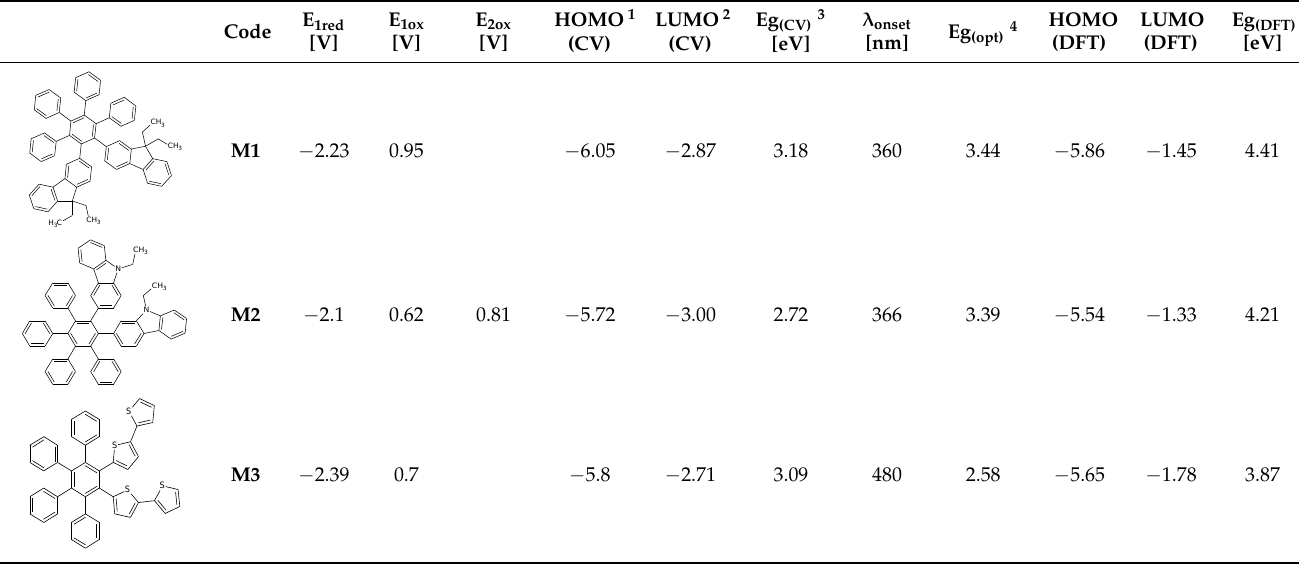
Table 2. Redox potentials, HOMO and LUMO energies and electrochemical band gaps (Eg).